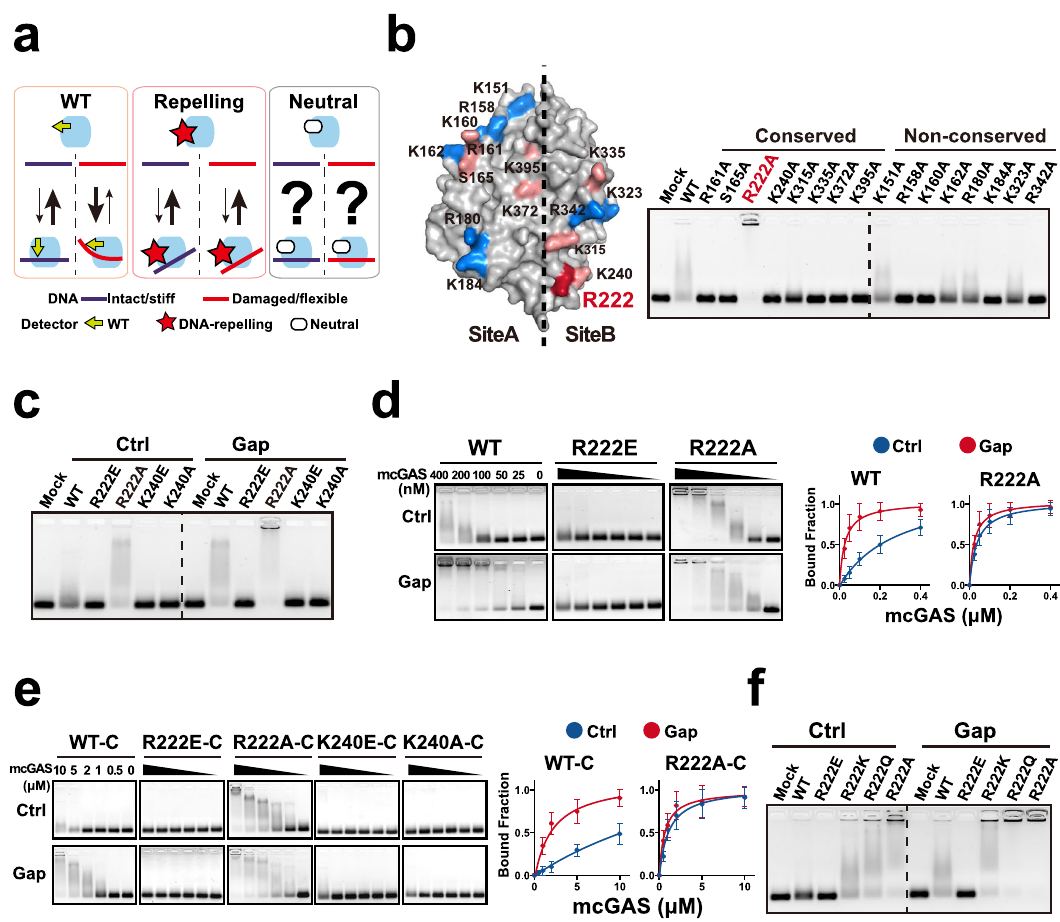
Fig. 4 | Substitution analyses identi fi ed a role of R222 in the DNA- fl exibility detection.a Schematicshowingthepotentialimpactsofdetectormutationsonthe protein – DNA binding. DDR protein classically changes the conformation of detector to deform DNAto integrate DFC. It is energetically unfavourableto curve the intact/stiff DNA. Hence, the intact/stiff and damaged/ fl exible DNAs form unstableandstableprotein – DNAcomplexes,respectively.Andtheoveralleffectof detectormightdecrease theenzyme-bindingand-activatingbyintactDNA,and/or increase the binding and activating by damaged DNA. The substitutions of these residuestoacidicglutamine(E)usuallyshowtheDNA-repellingpotentials.But,the neutral substitutions might increase but not decrease the enzyme-binding and/or activating by DNAs, providing a strategy to evaluate the role of single residue of cGAS. b Left: Surface structure of mcGAS to show the location of DNA-binding